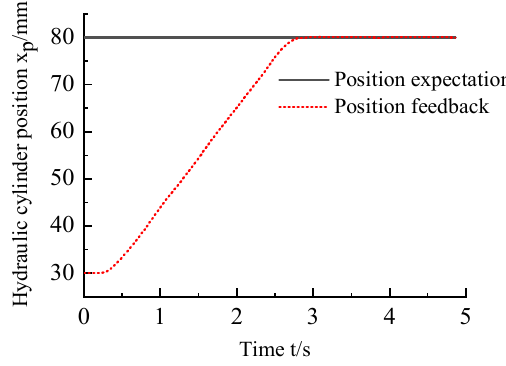
Figure 19. Response curve of step